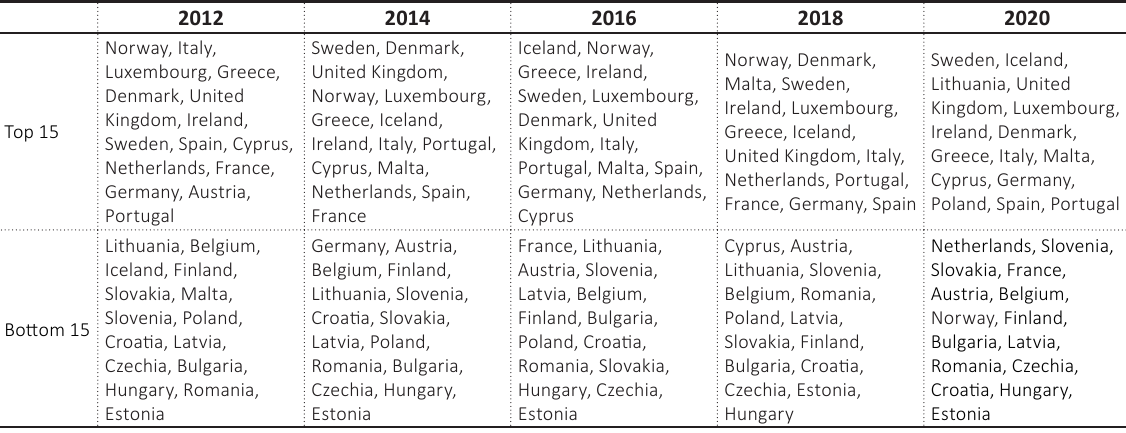
Table 1. The top 15 and bottom 15